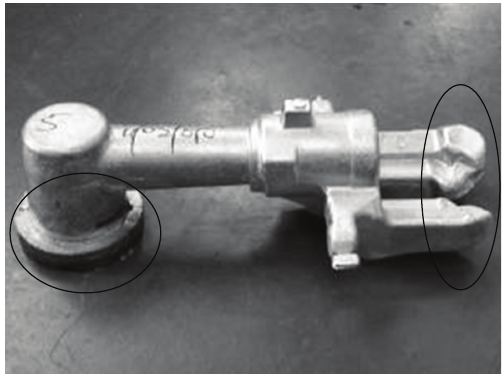
Figure 3: An example of a short fill defect brake caliper casting produced during trials with the CSIR-RCS-HPDC cell indicating a thin biscuit in conjunction with an incomplete casting.